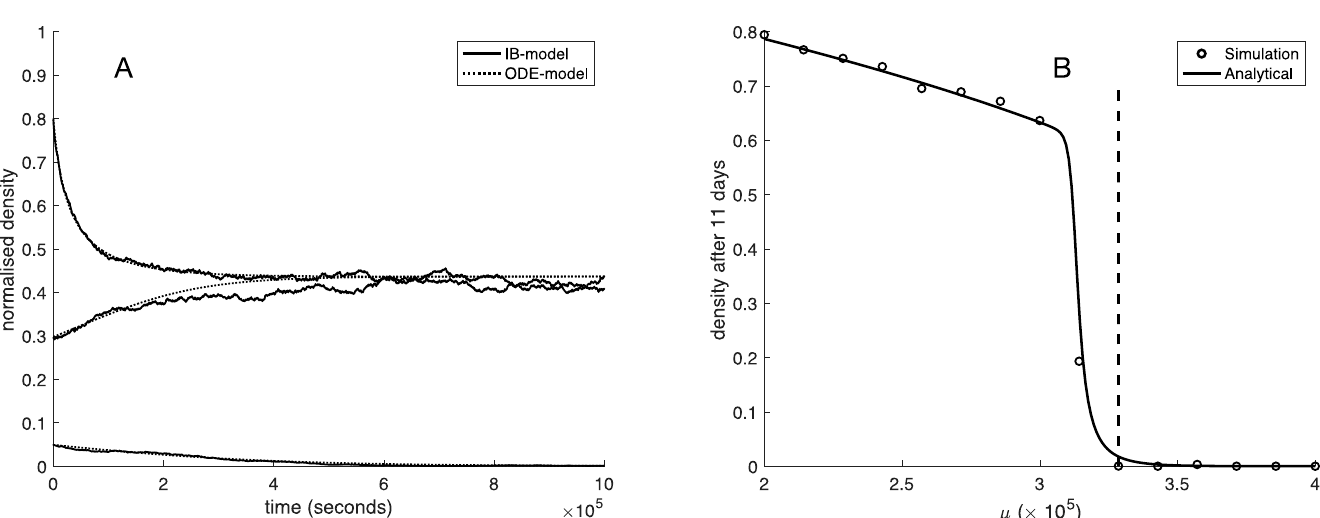
Fig 3. Comparison of the ODE-model and IB-model under long range dispersal. (A) The dynamics of the IB-model (dashed) and the numerical solution of (3) (solid) under long range dispersal for three different initial conditions. All parameter values are given in Table 1 and the death rate μ = 3.75 × 10 − 5 . (B) The population density after 11 days of the IB-model (circles) and the numerical solution of (3) (solid line) under long range dispersal and no cell migration when the death rate μ is varied. All other parameter values are given in Table 1.